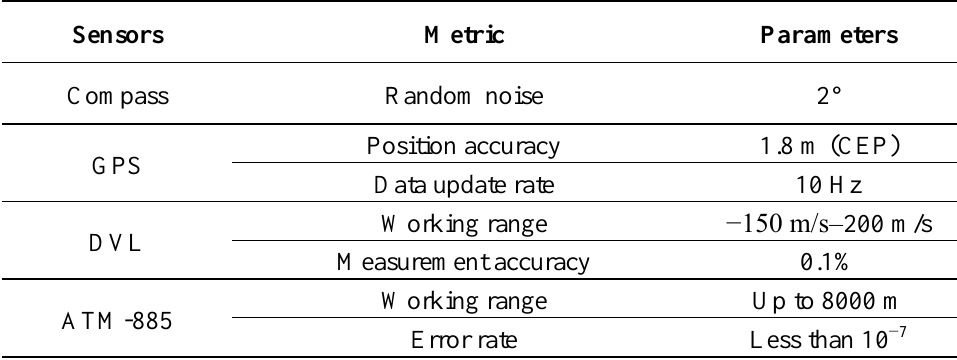
Table 1. The performance parameters of equipment used in